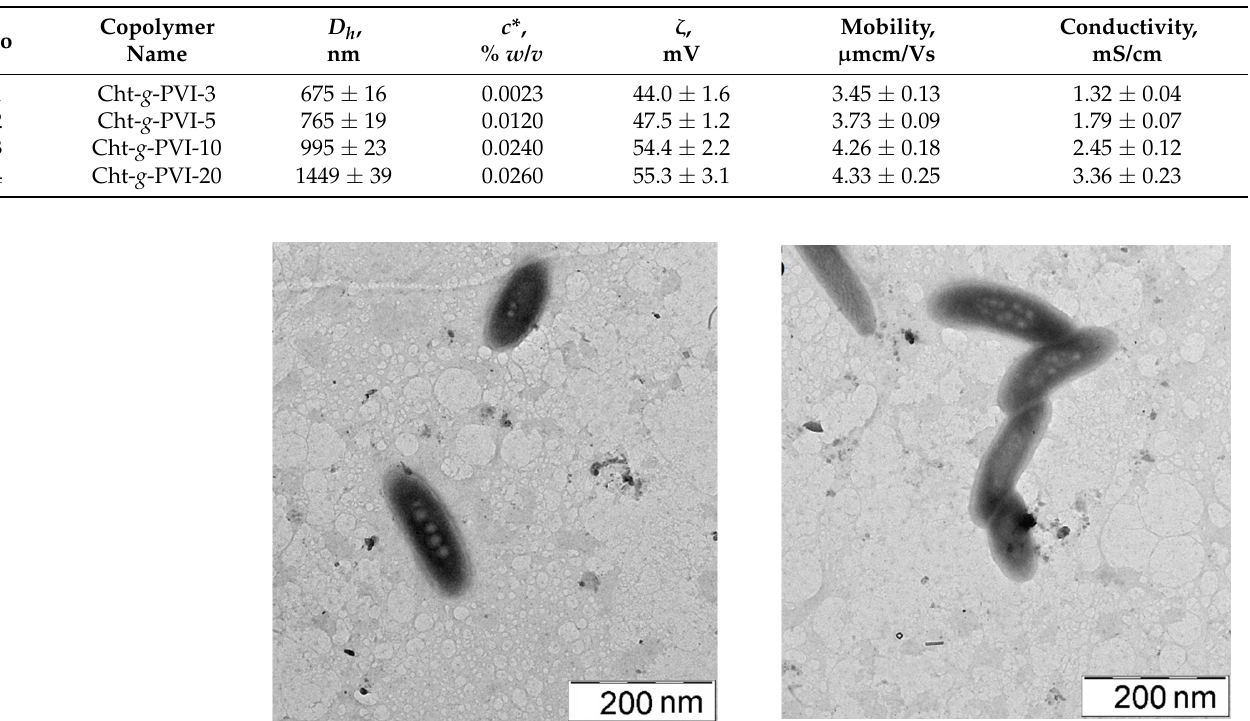
Table 3. The characterization of the 0.1% w / v Cht- g -PVI copolymer aqueous solutions (pH = 6.5 ± 0.02).